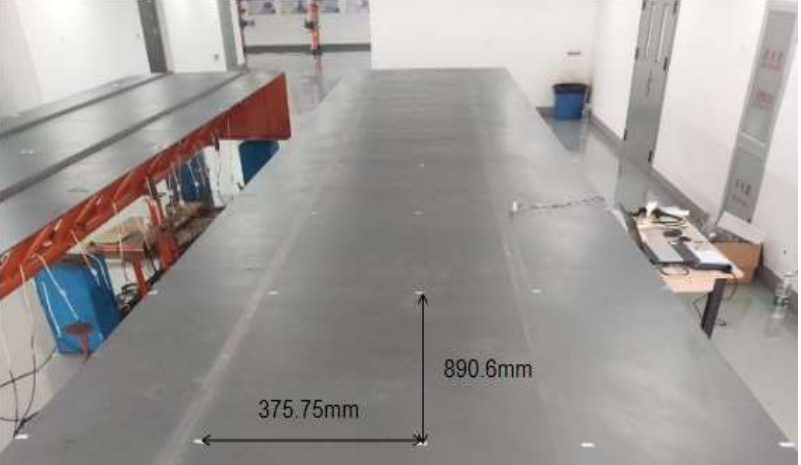
Figure 10. Arrangement of measurement points on bridge decks based on the uniform distribu- tion method.